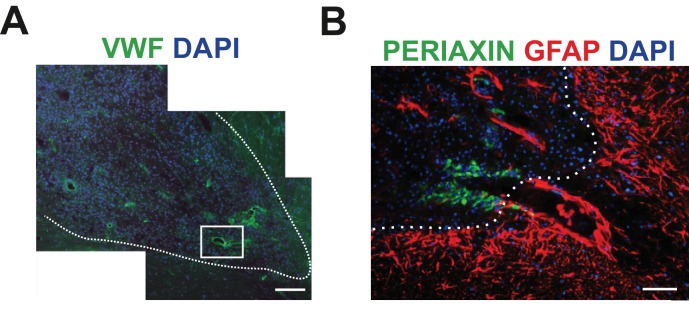
SCs-mediated remyelination is restricted to the vascular niche.(A) Immunodetection for vWF+ blood vessels within the lesioned area (scale bar 100 μm). (B) SCs preferentially occupy discrete areas where astrocytes were absent even around the same vessel (high magnification of boxed area in A, astrocyte enriched area of the edge of the lesion depicted by dotted line, scale bar 50 μm).